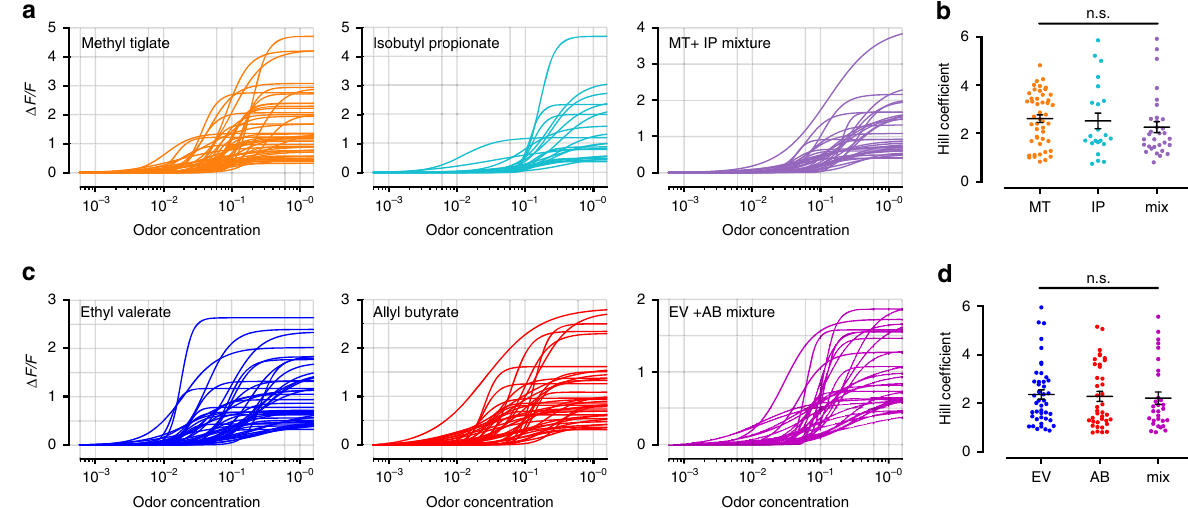
Fig. 4 Hill coef fi cients of odor responses in OSN axon terminals. a Example response curve fi ts from individual OSNs for odors in Table 1 and their mixture. b Hill coef fi cient distributions from the individual OSNs plotted in part ( a ) ( n = 48 for Methyl tiglate, n = 22 for Isobutyl propionate, n = 32 for MT + IP mixture; P > 0.05 for all comparisons; two-sided rank-sum test). Data are presented as mean ± SEM c Example response curve fi ts from individual OSNs for odors in Table 2 and their mixture. d Hill coef fi cient distributions from the individual OSNs plotted in part ( c ) ( n = 44 for Ethyl valerate, n = 39 for Allyl butyrate, n = 30 for EV + AB mixture; P > 0.05 for all comparisons; two-sided rank-sum test). Data are presented as mean ±